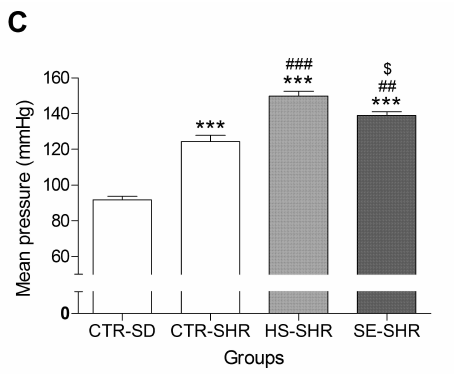
Figure 6. Effect of Salicornia europaea extracts (SE) on the systolic blood pressure ( A ); diastolic blood pressure ( B ); and mean arterial pressure ( C ) in the spontaneous hypertensive rat group (CTR–SHR) compared to the values in the high edible salt fed group (HS–SHR, 800 mg/kg/day) and the SE group (SE–SHR, 1400 mg/kg/day). Values are expressed as mean ˘ SEM. “***” stands for p < 0.001 vs. CTR-SD. “##” and “###” stands for p < 0.01 and p < 0.001 vs. CTR–SHR respectively. “$” stands for